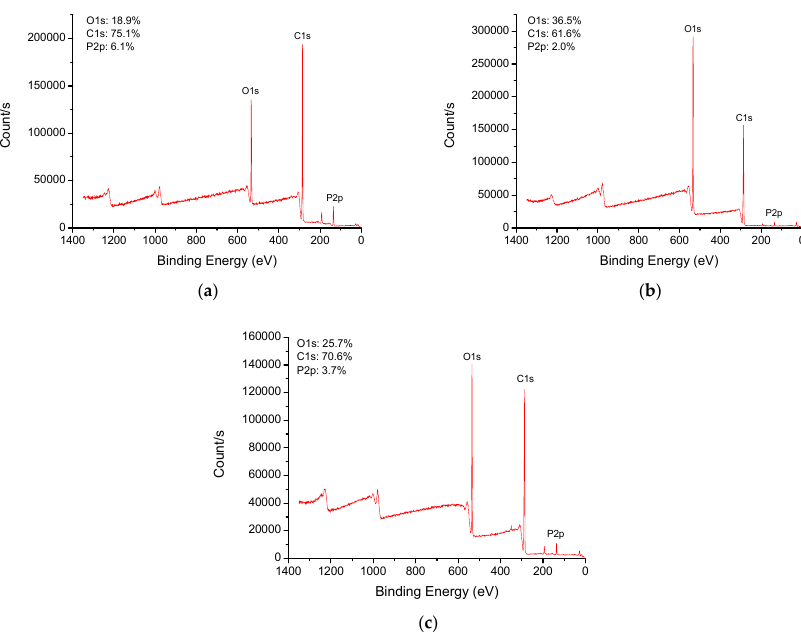
Figure 7. X ‐ ray photoelectron spectroscopy survey results and the ratios of carbon, oxygen and phosphorous atoms ( a ) before the permeation experiment; ( b ) conventional PIM with 5 M HCl as the strip solution; ( c ) PIMSD with 5 M HCl as the strip solution.